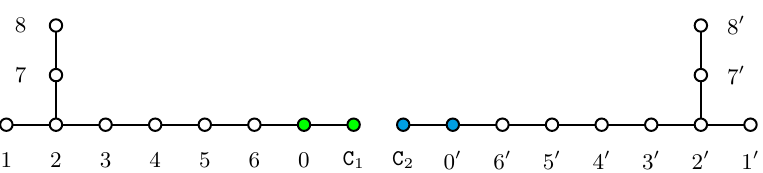
Figure 5. Extended diagram with A 1 = (cid:14) 1 (cid:2) 0, A 2 = 0 (cid:2) (cid:14) 0 lattice II 1 ; 9 + II 1 ; 9 . Interestingly, these roots form a basis for II 2 ; 18 .